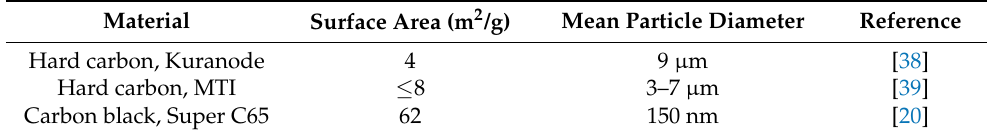
Table 1. Particle surface area and size range of hard carbon and carbon black applied herein. Material Surface Area (m 2